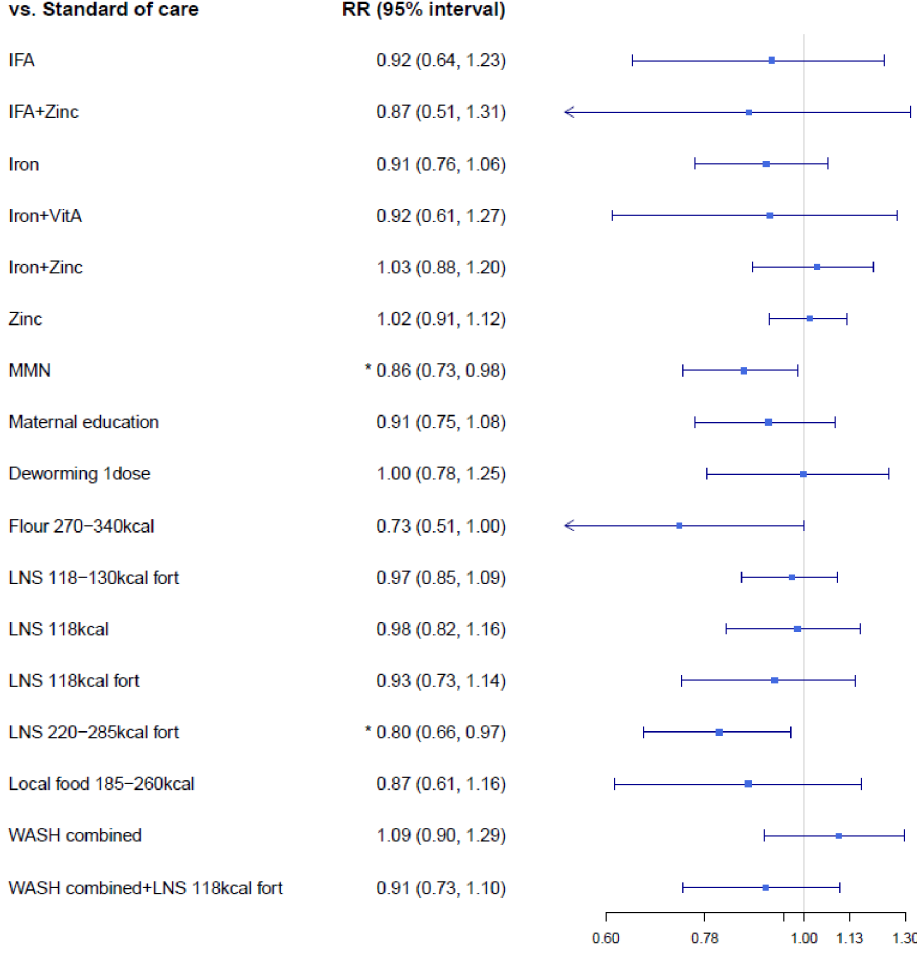
Figure 4. Forest plot for the effects of interventions on stunting (risk ratio), primary analysis. Vit. vitamin; IFA, iron and folic acid; LNS, lipid-based nutrient supplements; Fort, fortification; MMN, multiple micronutrients; WASH, – water treatment, toilet facilities, and handwashing. * Denotes values of risk ratio that do not contain the null effect of